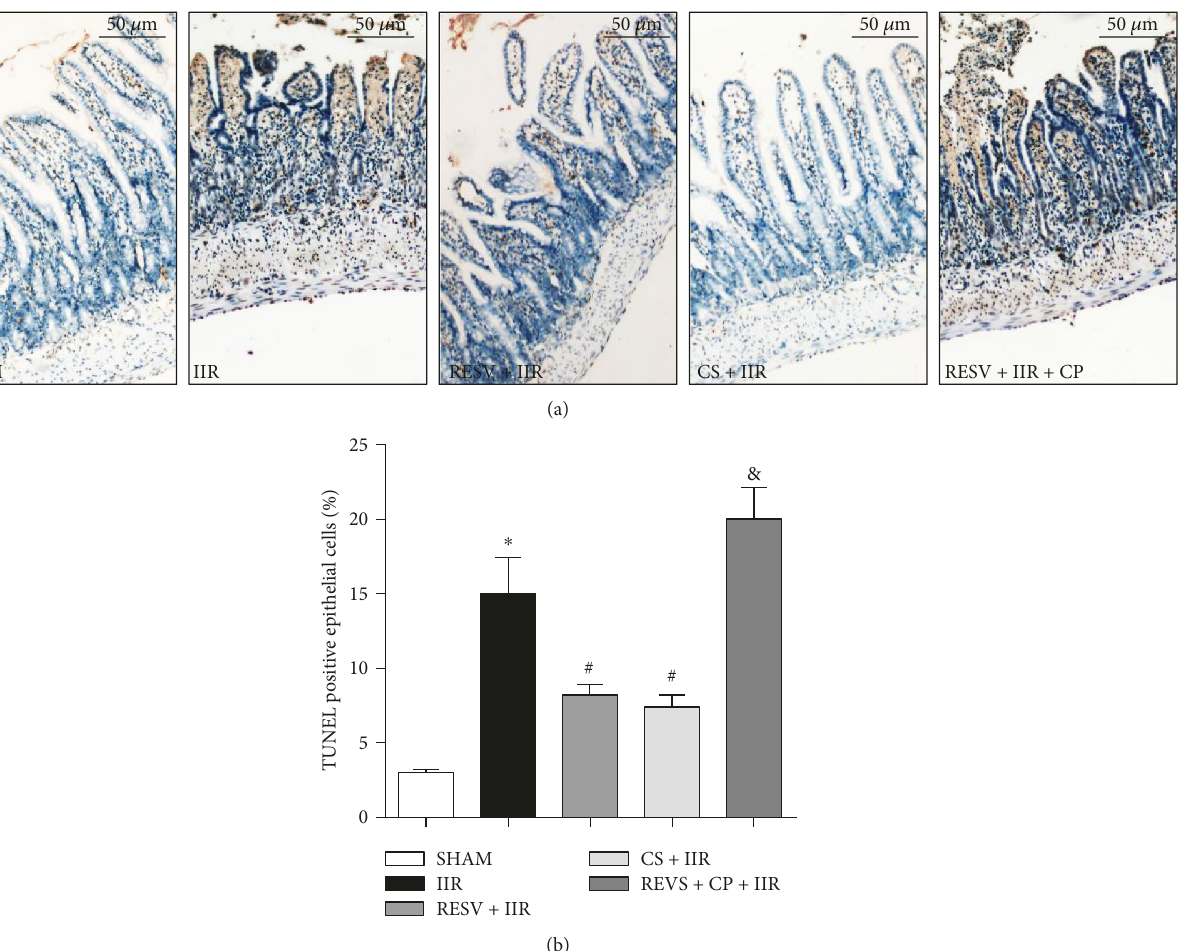
Figure 4: Resveratrol pretreatment reduced intestine cellular apoptosis. (a) Representative histological illustration for each group, TUNEL staining, magni fi cation: × 400. (b) TUNEL-positive cell ratio. IIR: intestinal ischemia-reperfusion; RESV: resveratrol; CP: compound 48/80; CS: cromolyn sodium. Data are expressed as the means ± SEM, n = 8 /group. ∗ P < 0 05 vs. sham group, # P < 0 05 vs. IIR group, & P < 0 05 vs. RESV+ IIR